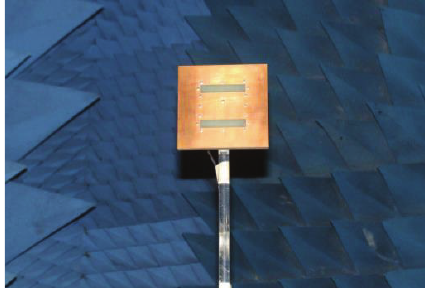
Figure 25: SIW antenna in the anechoic chamber.